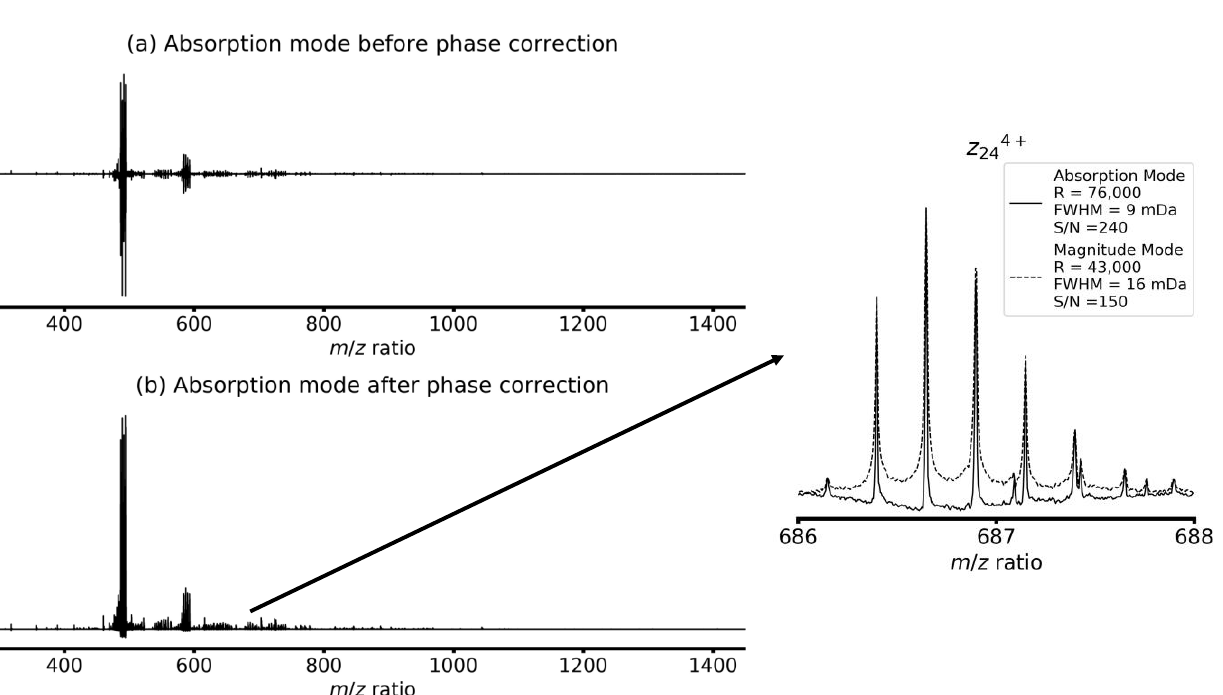
Figure 1. Tandem mass spectrum of the [M + 6H] 6+ histone peptides with ECD fragmentation in absorption mode ( a ) before phase correction and ( b ) after phase correction. Insert: zoom-in on the z 244+ fragment ion isotopic distribution of the monomethylated histone peptide (K7 1m), comparison between magnitude mode and phase-corrected absorption mode (FWHM: full-width at half-maximum).